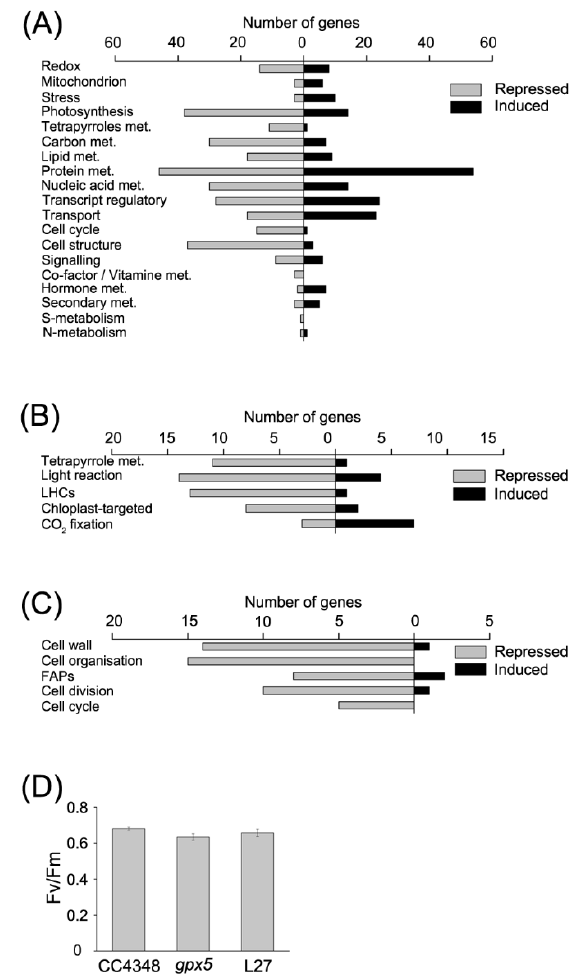
Figure 2. Functional analysis of differentially expressed genes in the gpx5 mutant compared to the parental strain CC4348 under laboratory growth conditions. ( A ) Functional subcategories of differentially expressed genes (DEGs) in the gpx5 mutant compared to the parental strain CC4348 under laboratory growth conditions. For clarity, only the genes with assigned functions are shown. Functional analysis of DEGs passing the criteria fold change greater than two (up) or less than 0.5 (down) with FDR < 1%, based on the MapMan functional classes; met, metabolism. ( B ) List of the DEGs related to photosynthesis and tetrapyrrole metabolism in the gpx5 mutant compared to the parent strain CC4348 under laboratory growth conditions. LHC, light-harvesting complex. ( C ) List of the DEGs related to cell structure and the cell cycle in the gpx5 mutant compared to the parental strain CC4348 under laboratory growth conditions. FAPs, flagellar-associated proteins. ( D ) The maximum efficiency of PSII (Fv/Fm) of CC4348, the gpx5 mutant, and L27 cells at a density of 2 × 10 6 cells mL −1 in exponential phase under laboratory growth conditions. The error bars in the graph represent standard deviations of three biological replicates.